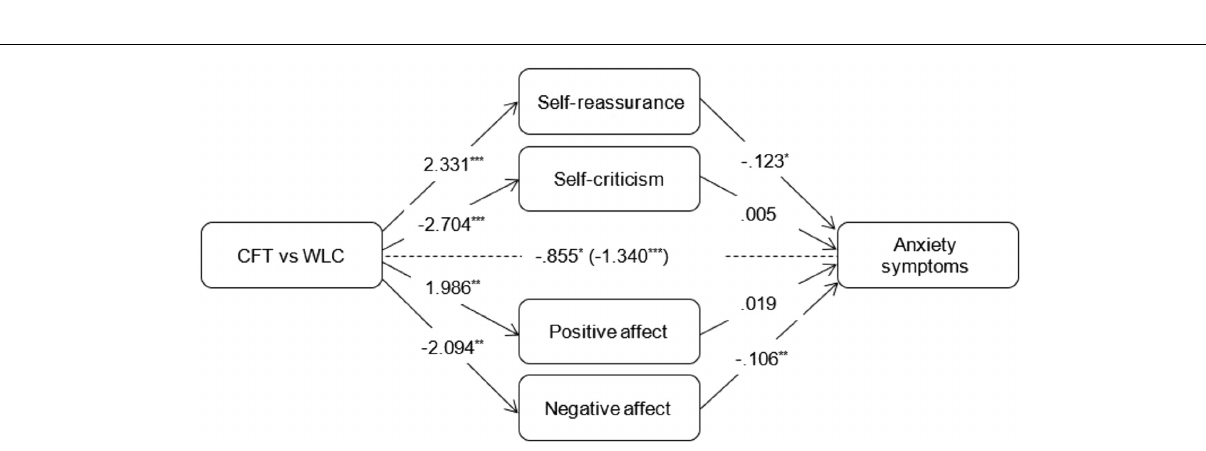
Frontiers in Psychology |